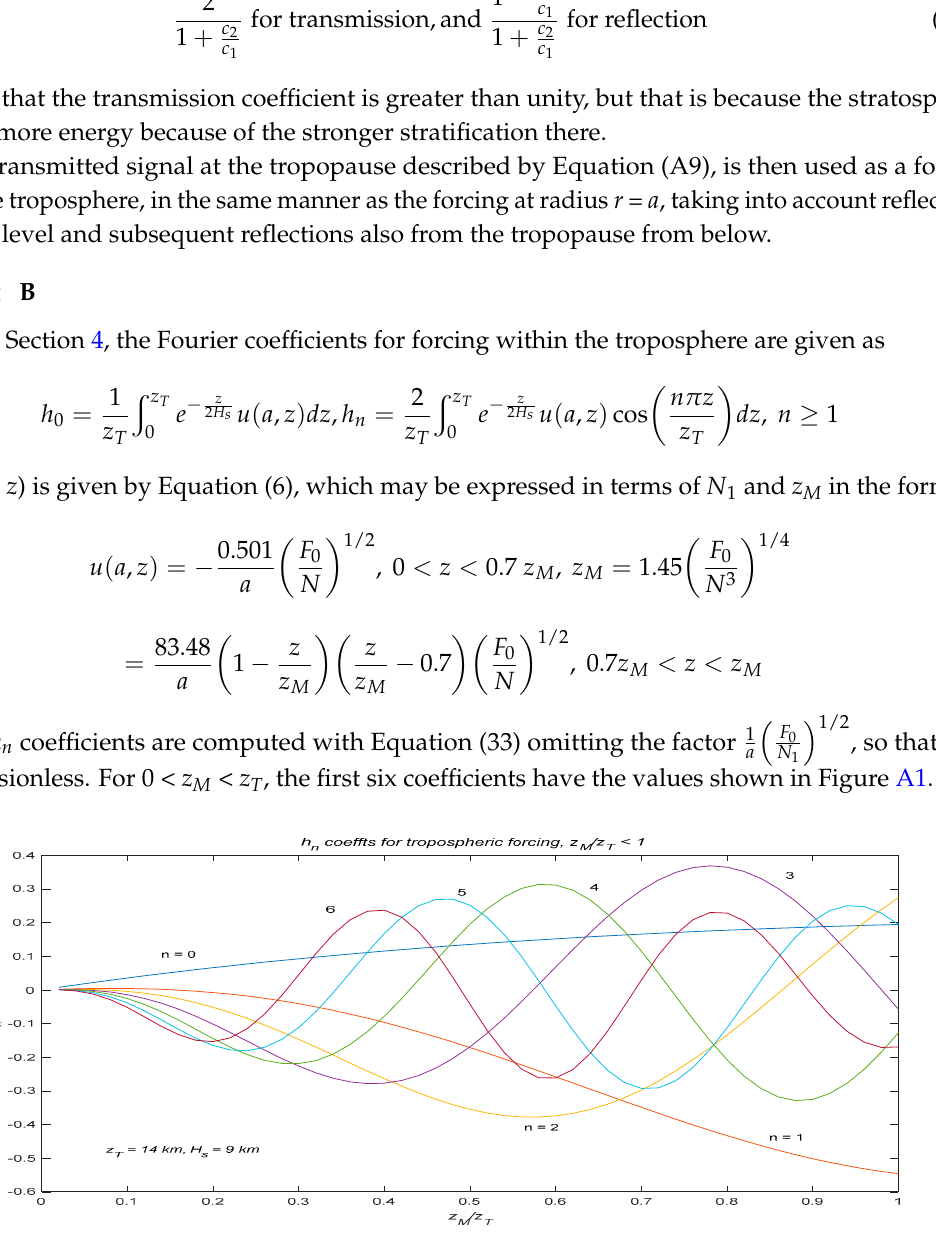
Figure A1. Values of the first six Fourier coefficients h n for eruptions that are contained within the troposphere, for a scale height H s = 9 km. Note the dominance of modes 1 and 2, and the increasing values as z M approaches z T